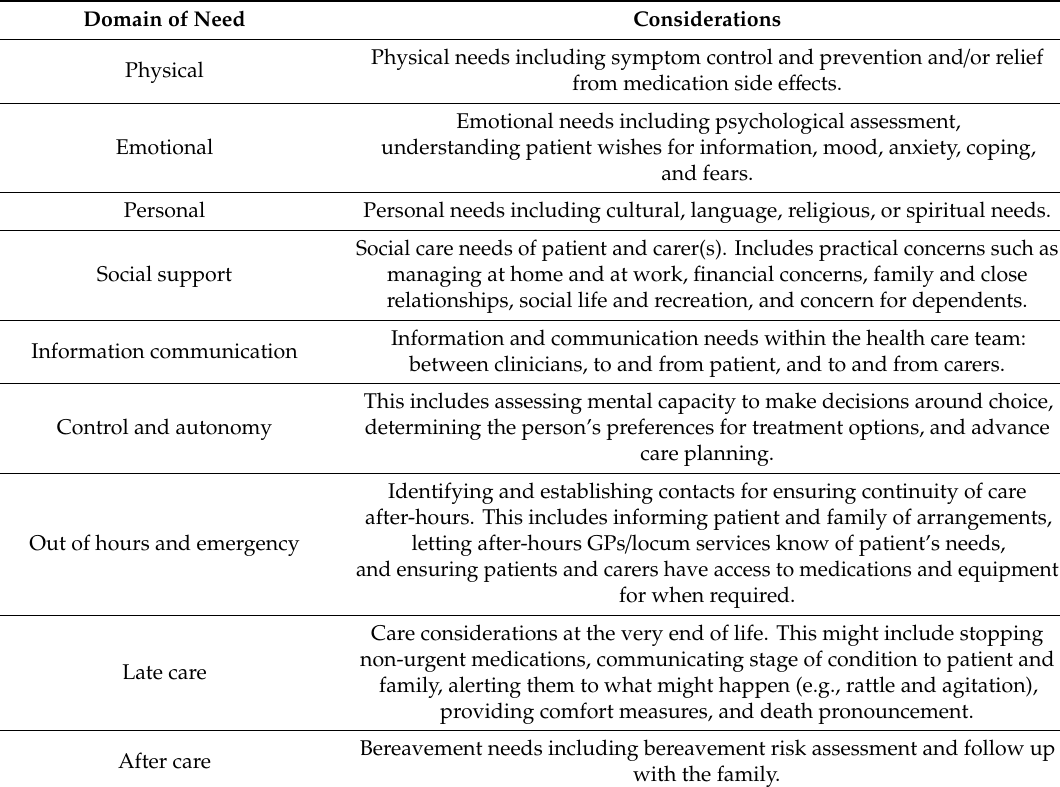
Table 1. PEPSI-COLA aide memoire for holistic palliative care patient assessment